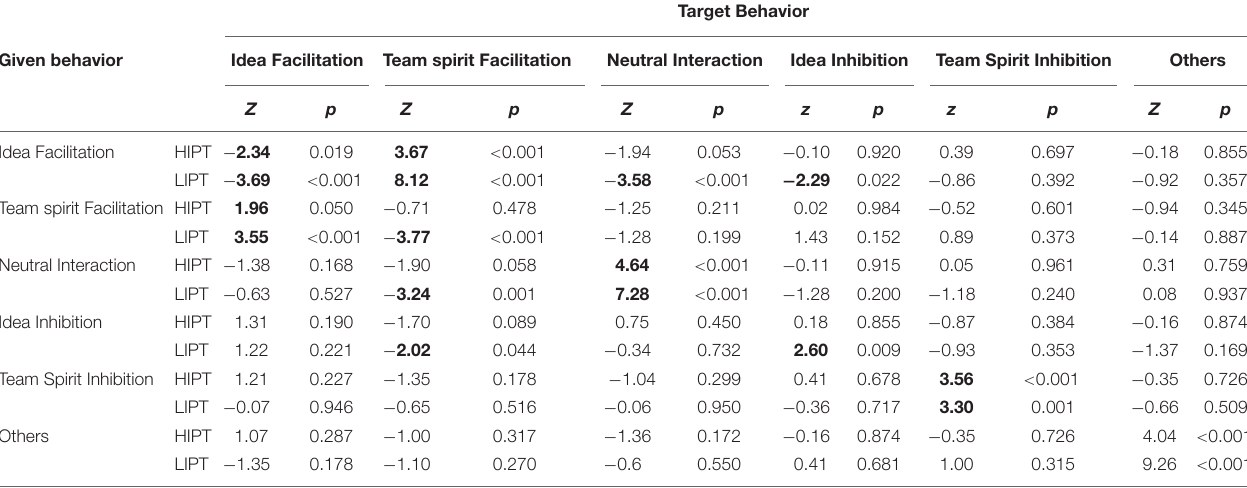
TABLE 3 | Comparison of adjusted residuals ( z -scores) of behavior transitions between higher and lower innovative-performing teams.